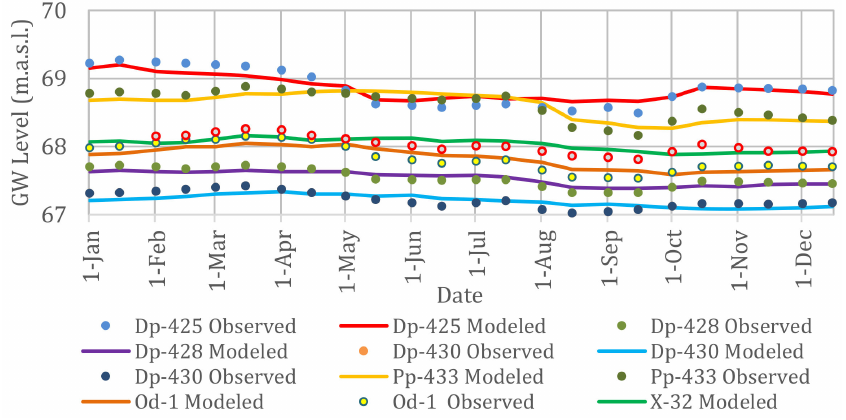
Figure 8. Observed and modeled groundwater levels at observation wells Dp-425, Dp-428, Dp-430, Pp-433, Od-1 and X-32 during the studied period (1 January to 31 December